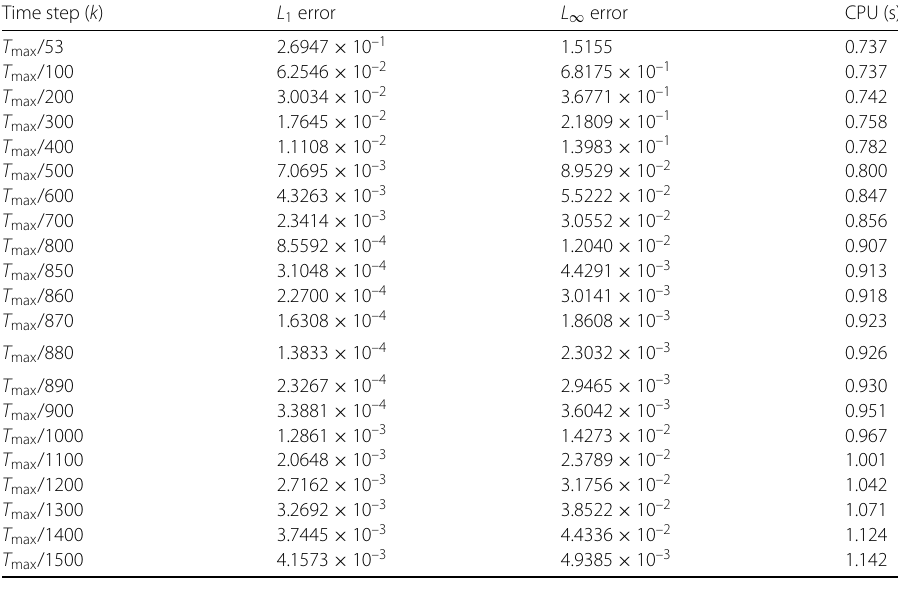
Table 10 L 1 and L ∞ errors CPU time at some different values of time-step size k for Problem 1 with ρ = 10 4 at time 2.5 × 10 –3 with spatial mesh size σ = 2.0 and h = 0.01 using FTCS with